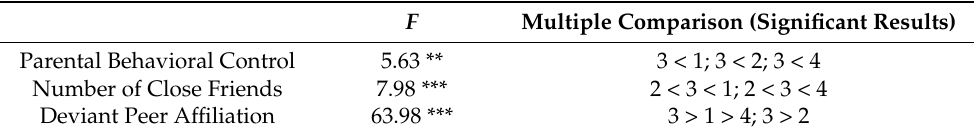
Table 3. Differences between the bullies, victims, bullies-victims, and non-status groups ( n = 3799). F Multiple Comparison (Significant